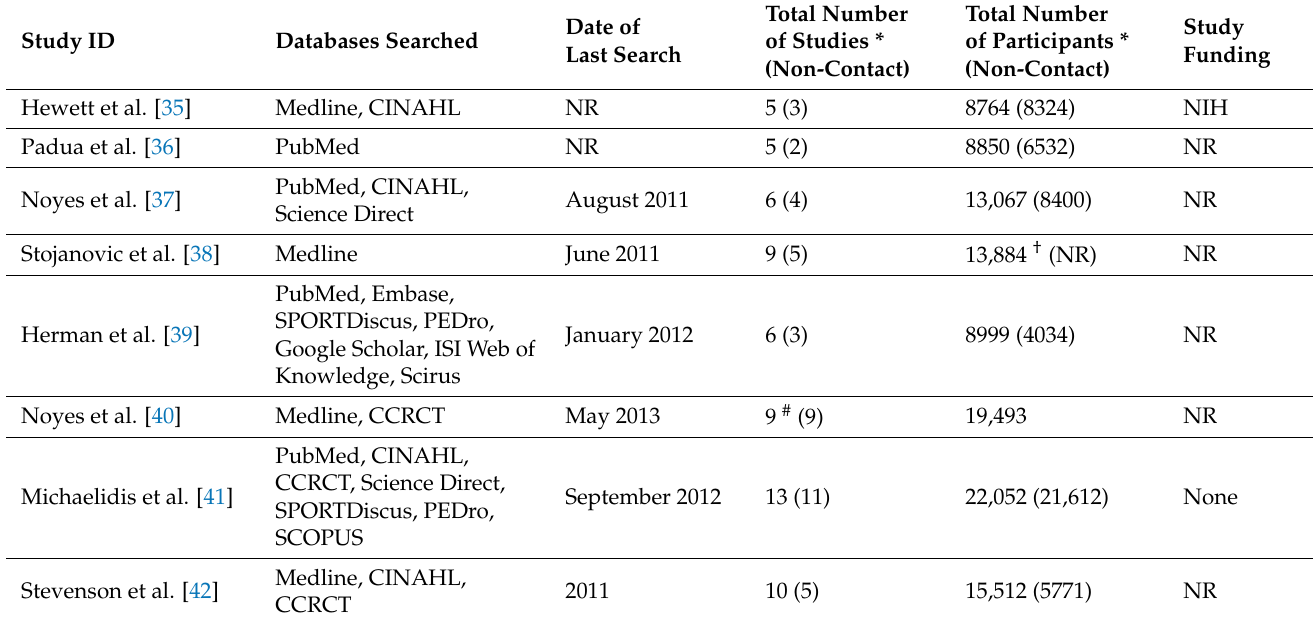
Table 1. Characteristics of the included systematic reviews.